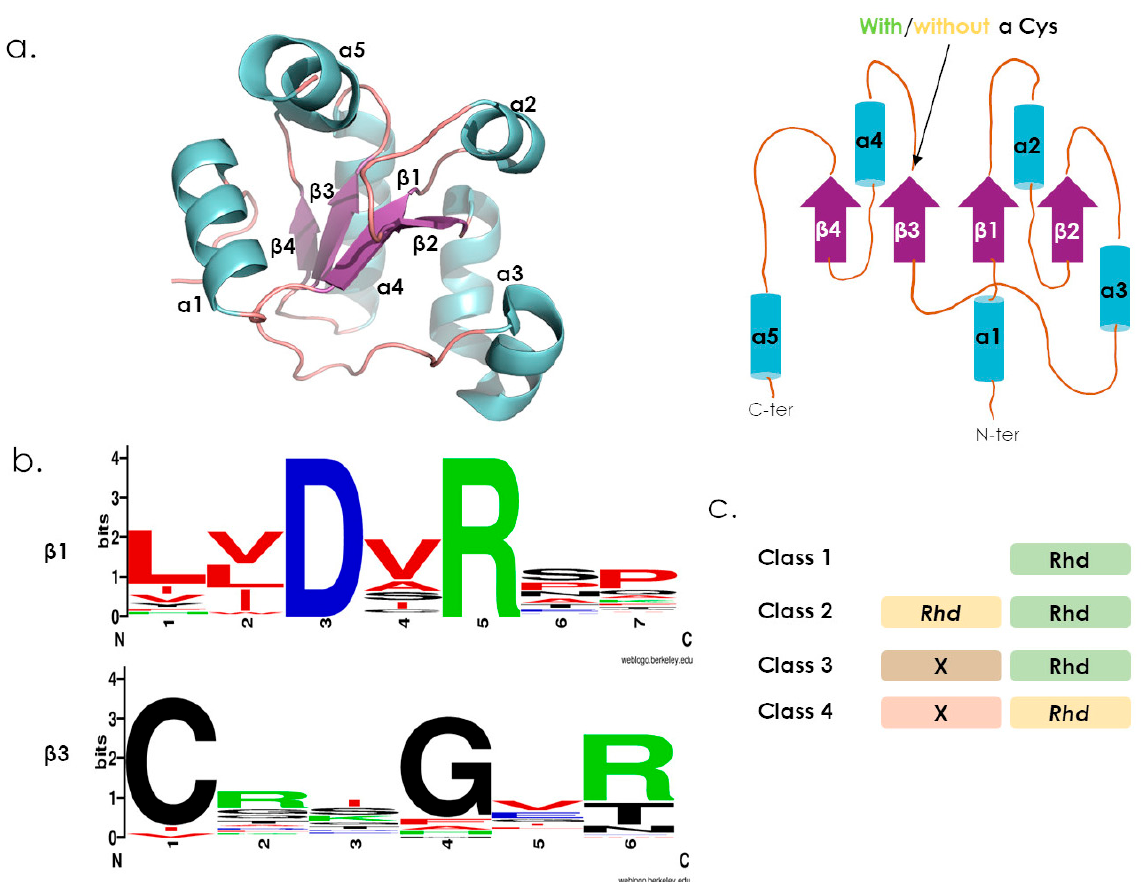
Figure 1. Rhodanese-fold features of Rhd-containing proteins. ( a ) 3D structure of TSTD1 (PDB 6BEV), with its topological representation. ( b ) WebLogo-generated representation (https://weblogo.berkeley.edu/logo.cgi, accessed on 07 October 2022) of the patterns issued from a multiple alignment of 50 sequences (identified by Blast with TSTD1 as template, UniProt, https://www.uniprot.org/, accessed on 20 September 2022) that cover the two structural regions located at the end of β -1 and β -3 strands in Rossmann-like fold. ( c ) The different subclasses of Rhd domain-containing proteins. Active Rhd domains are represented in green, inactive Rhd domains are in yellow, other structural domains (X) are represented in brown and